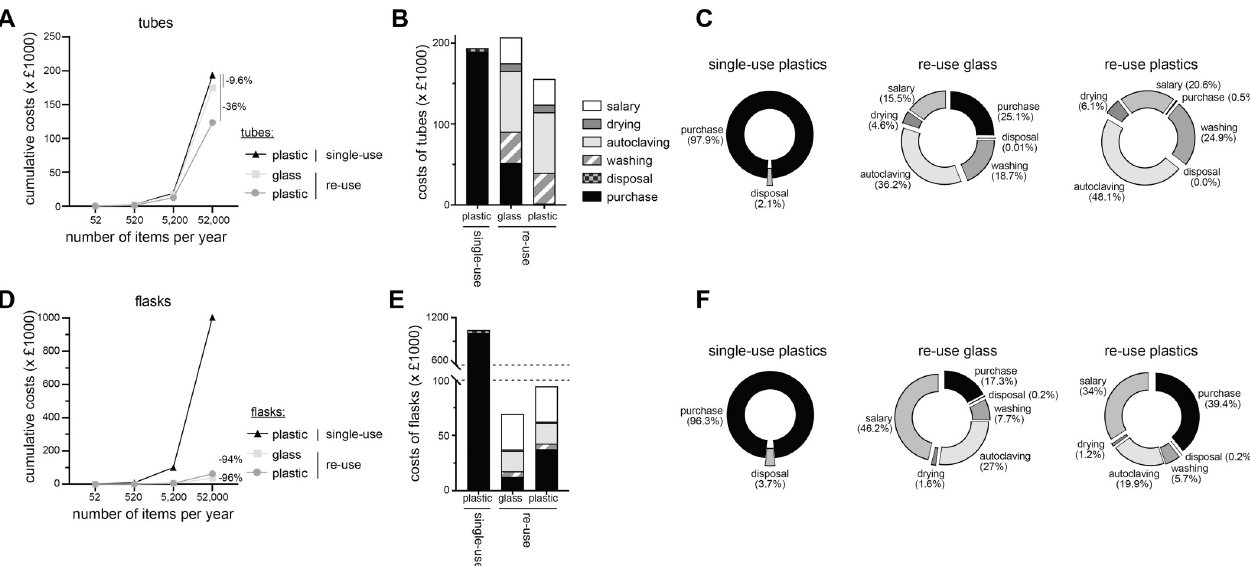
Fig 3. Costs associated with single-use and re-use of tubes and flasks for 10 years. ( A ) Running costs of a 10-year period for 50mL conical tubes excluding costs associated with salary of support staff for re-use scenario. ( B-C ) Costs of tube per life cycle stage (production, washing, autoclaving, drying, and disposal) including salary for technical staff (B) and percentage of total costs (C) for the 3 scenarios of A. ( D-F ) similar to A-C for 1L conical